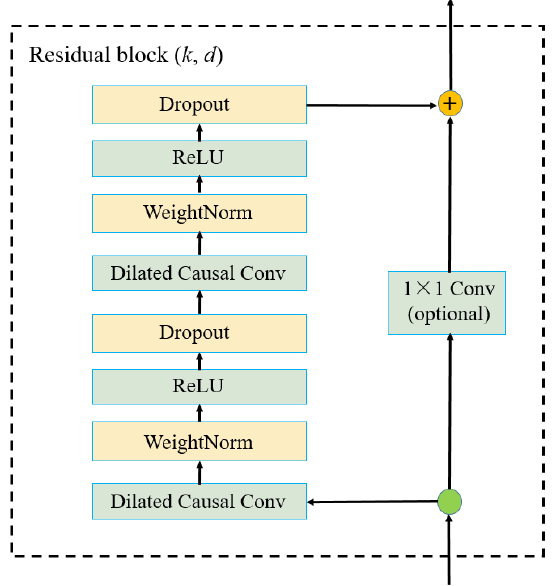
Figure 1. Schematic diagram of TCN model structure.